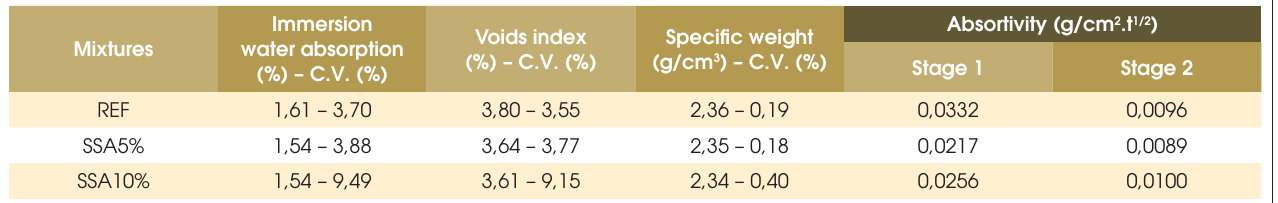
Table 6 – Physical properties of REF, SSA5% and